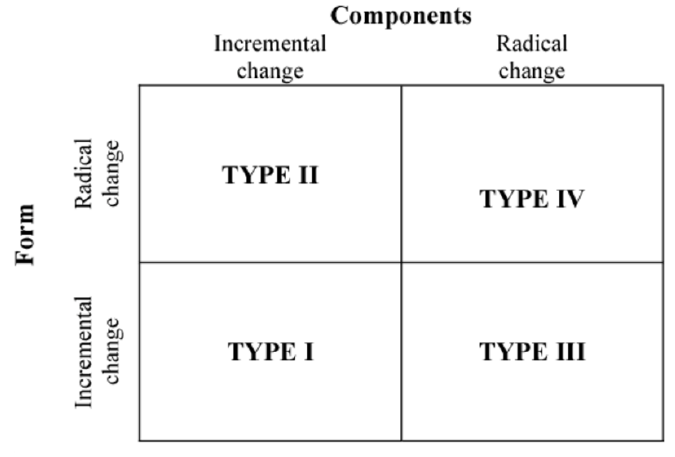
Figure 1. Matrix system of classification of product innovation, Source: Harbour and Blackman,